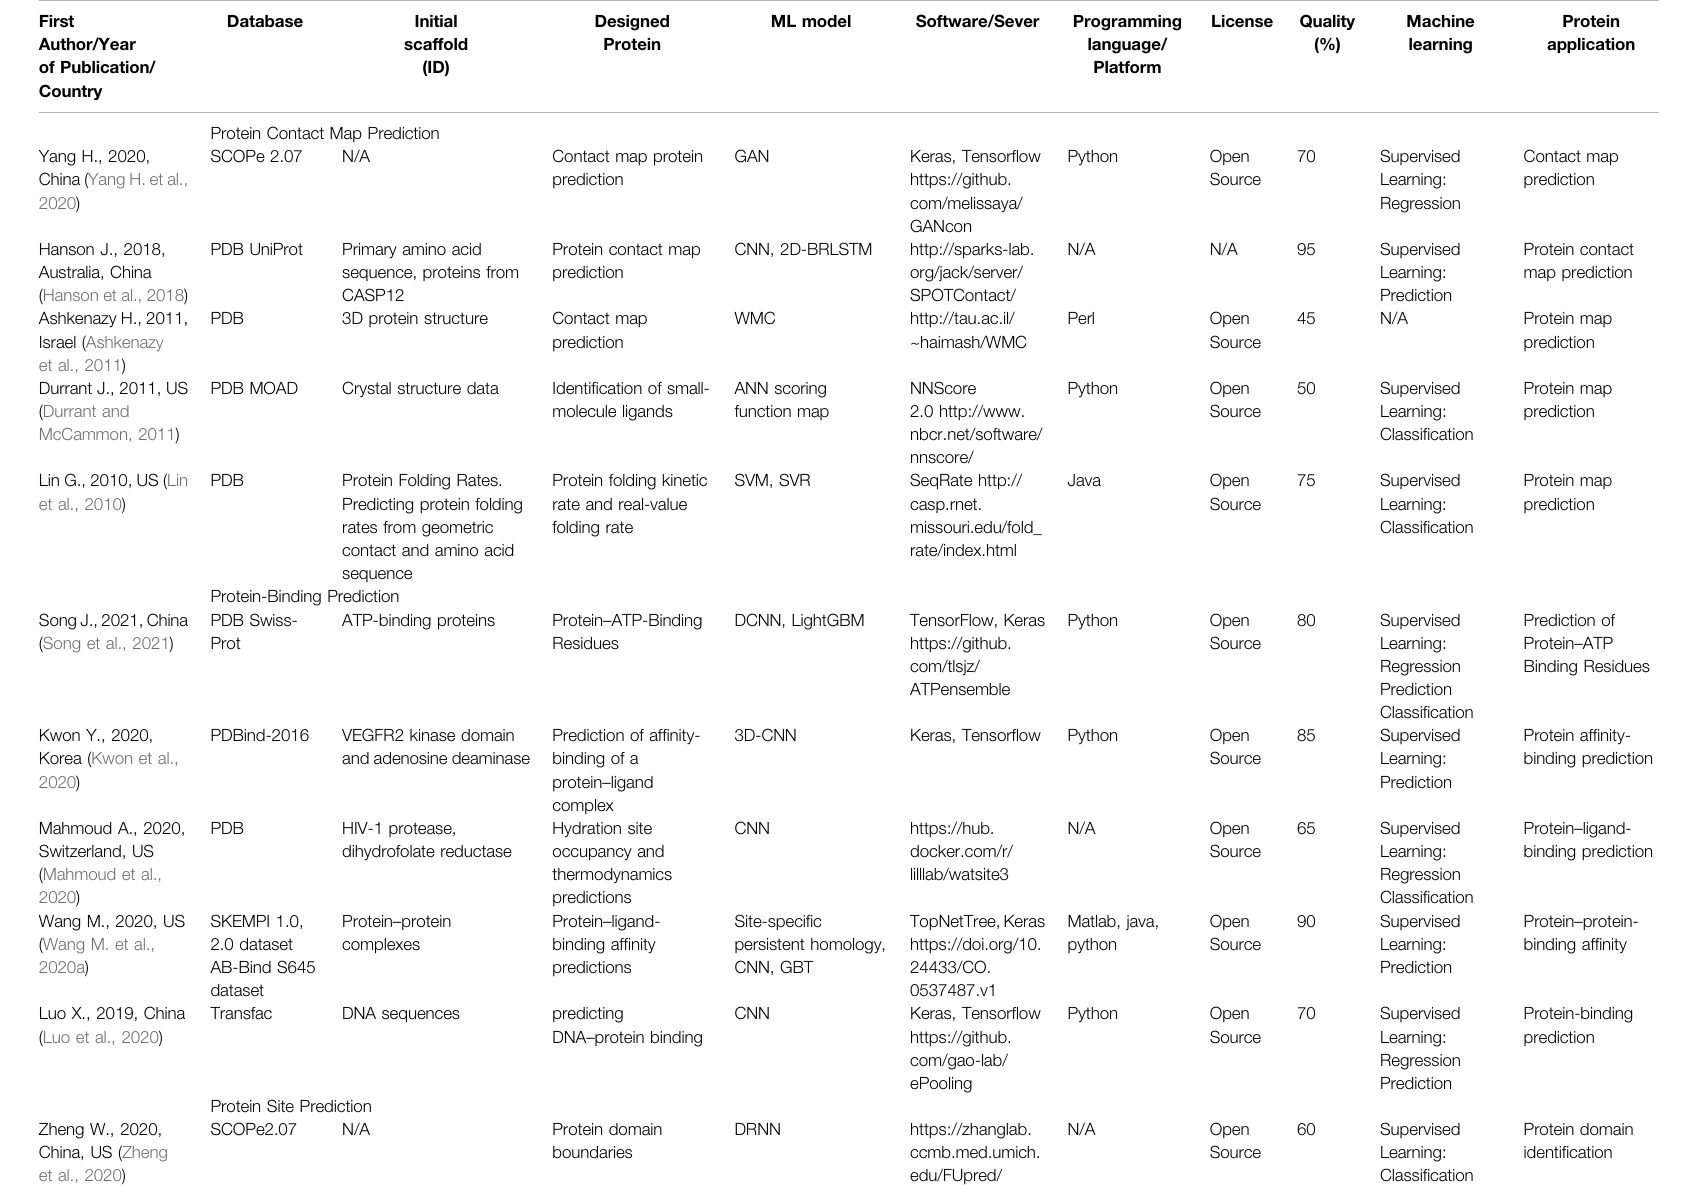
TABLE 6 | An overview of the protein contact map prediction, protein-binding prediction, protein site prediction, and genomics articles with the quality